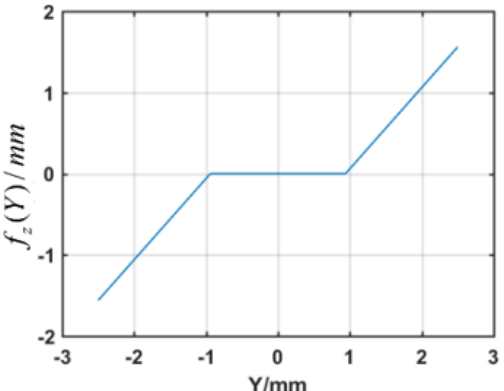
Figure 5. Effect of uniform wear of tooth surface on meshing stiff-